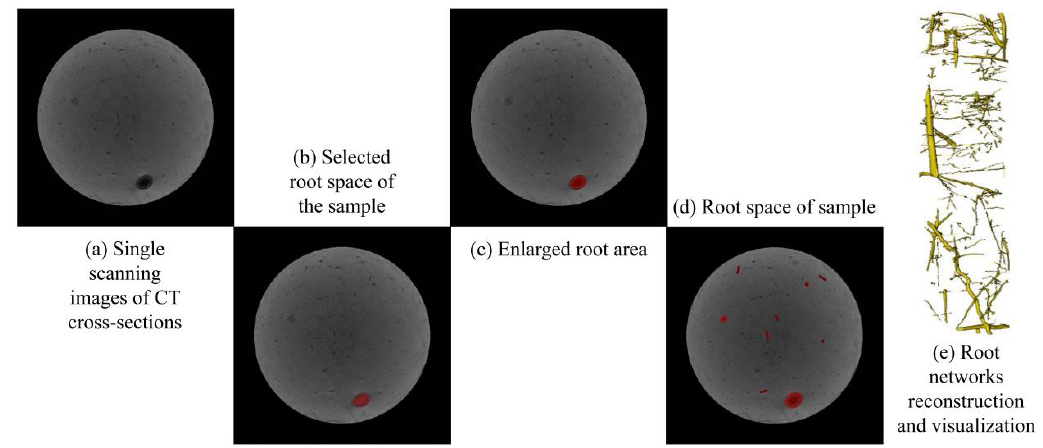
Figure 4. The process of reconstruction and visualization of root systems